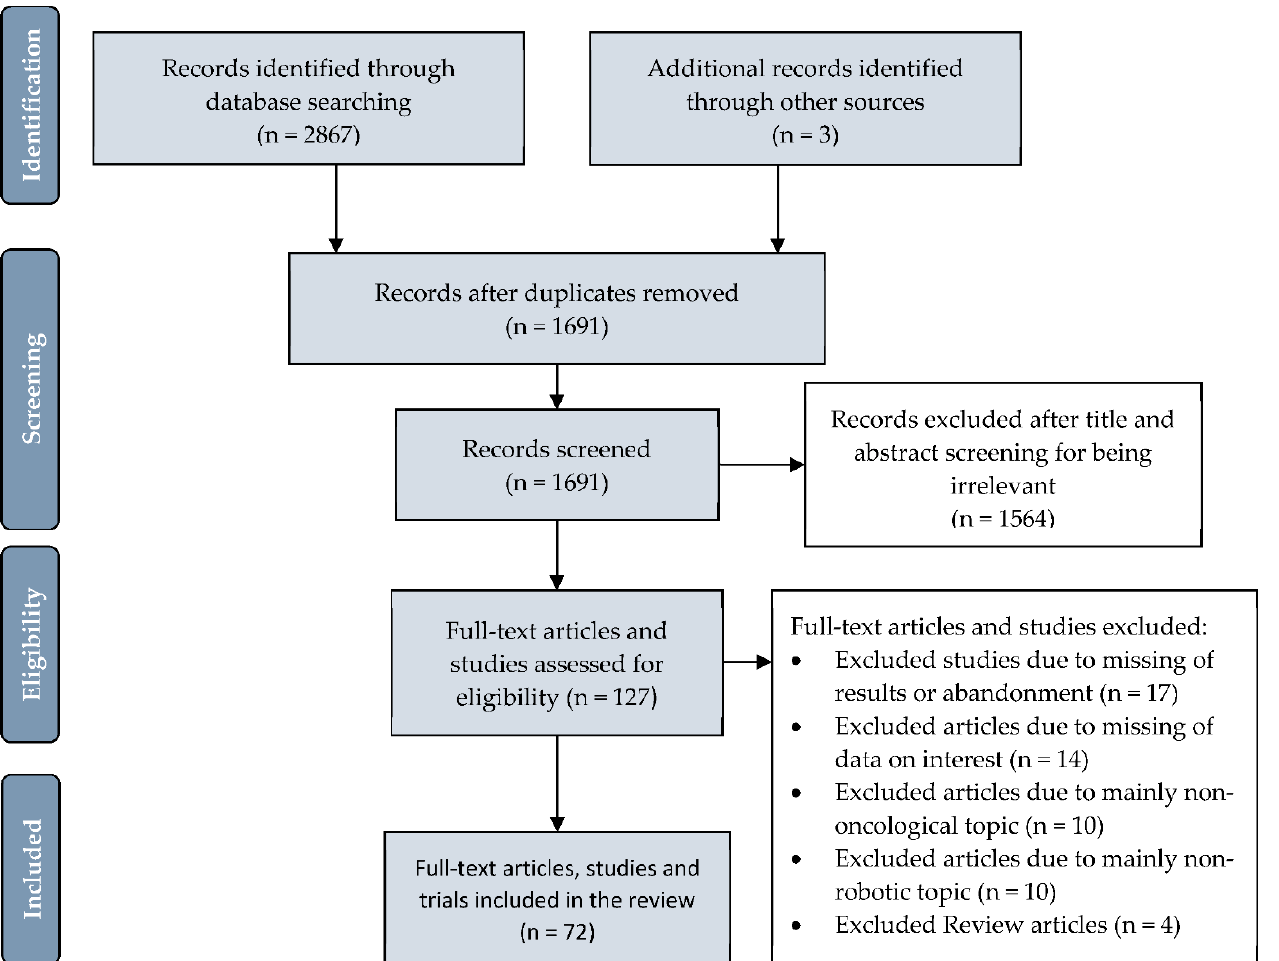
Figure 2. PRISMA (Preferred Reporting Items for Systematic Reviews and Meta-Analyses) flowchart depicting the number of identified articles and trials, those screened and final number included in the systematic review.